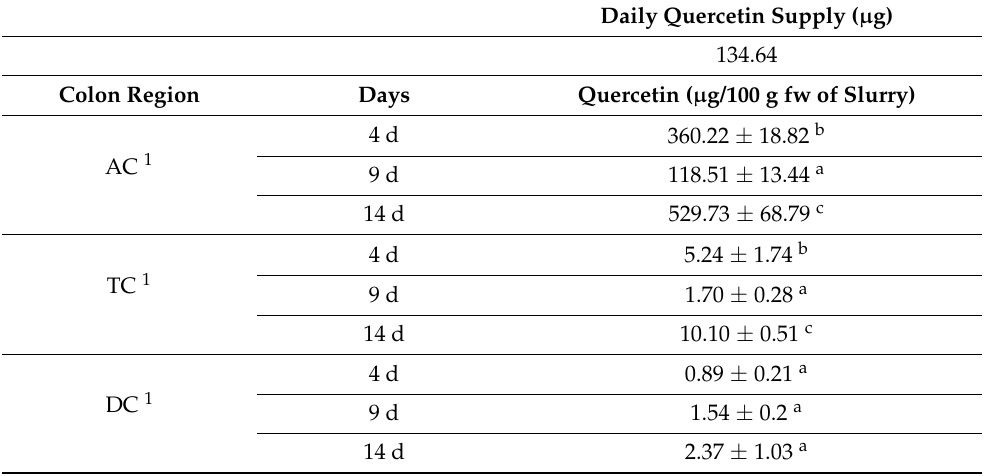
Table 3. Daily quercetin (Q) supply and evolution during a dynamic in vitro colonic fermentation of HPP-treated onion